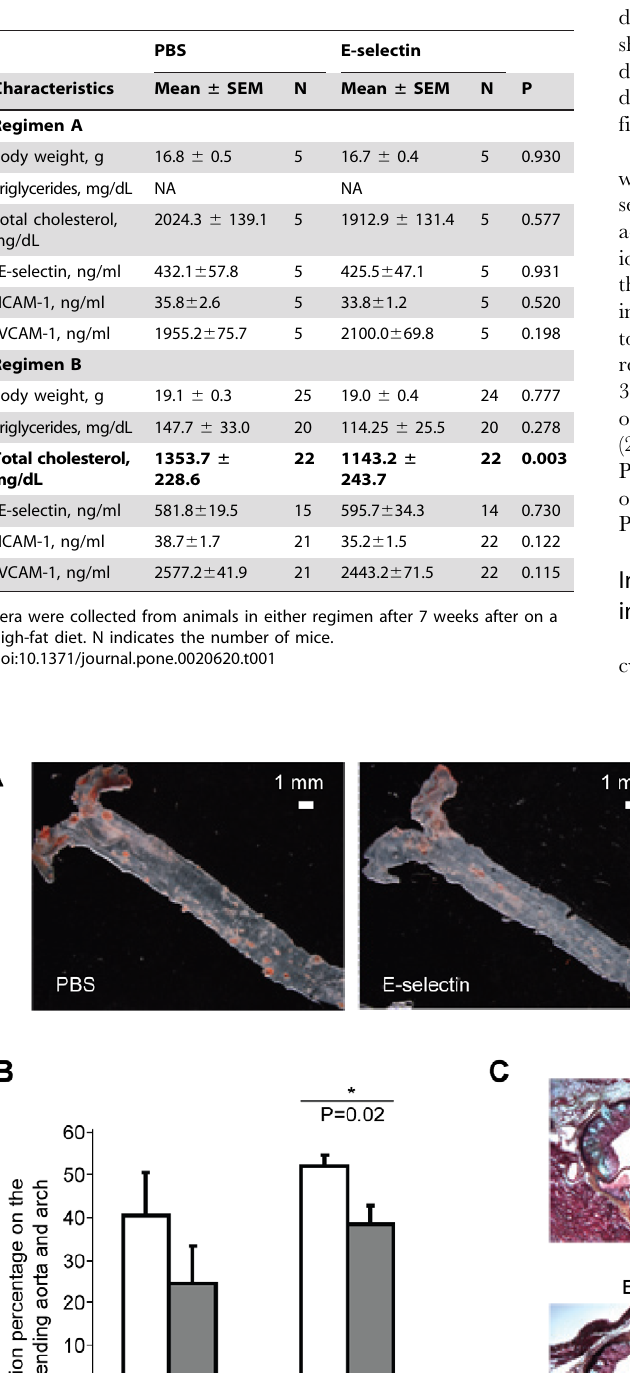
Table 1. Analysis of serum lipids and cell adhesion molecules.